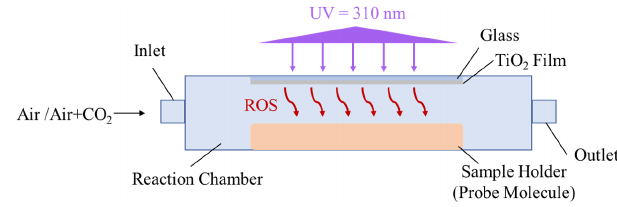
Figure 1. The schematic of the flow cell reaction chamber for gaseous ROS